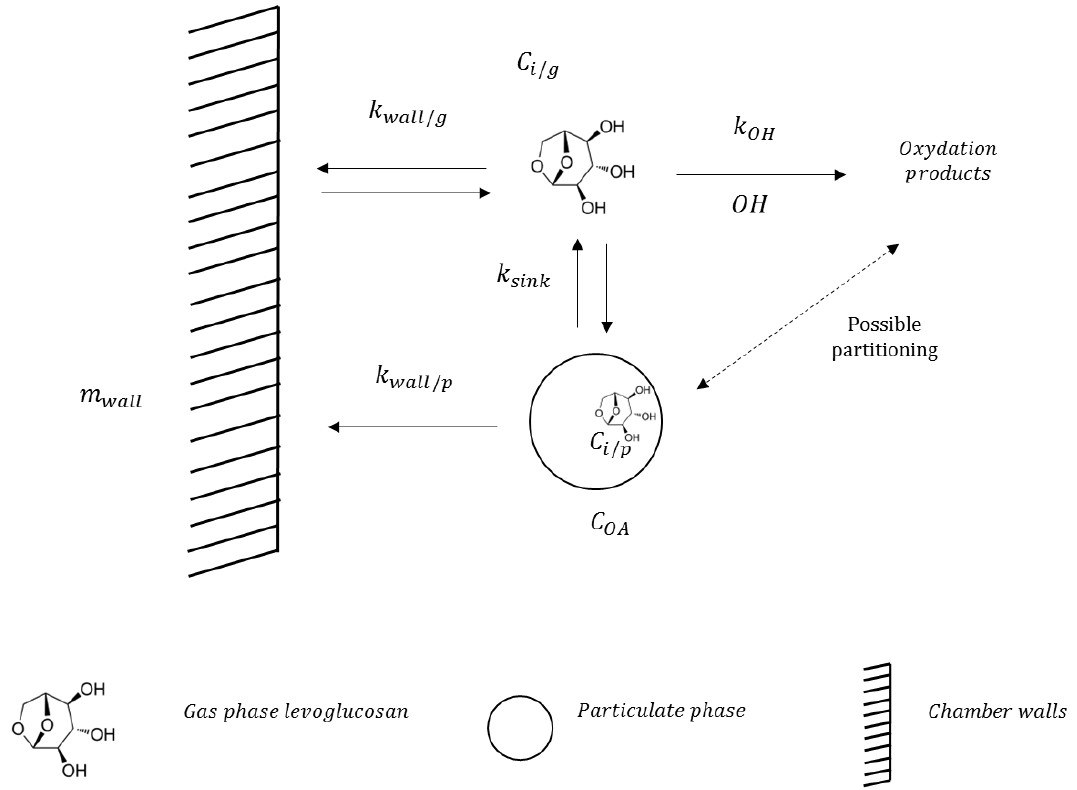
Figure 1. Theoretical framework representing the interactions between the gas phase, the particle phase, and the